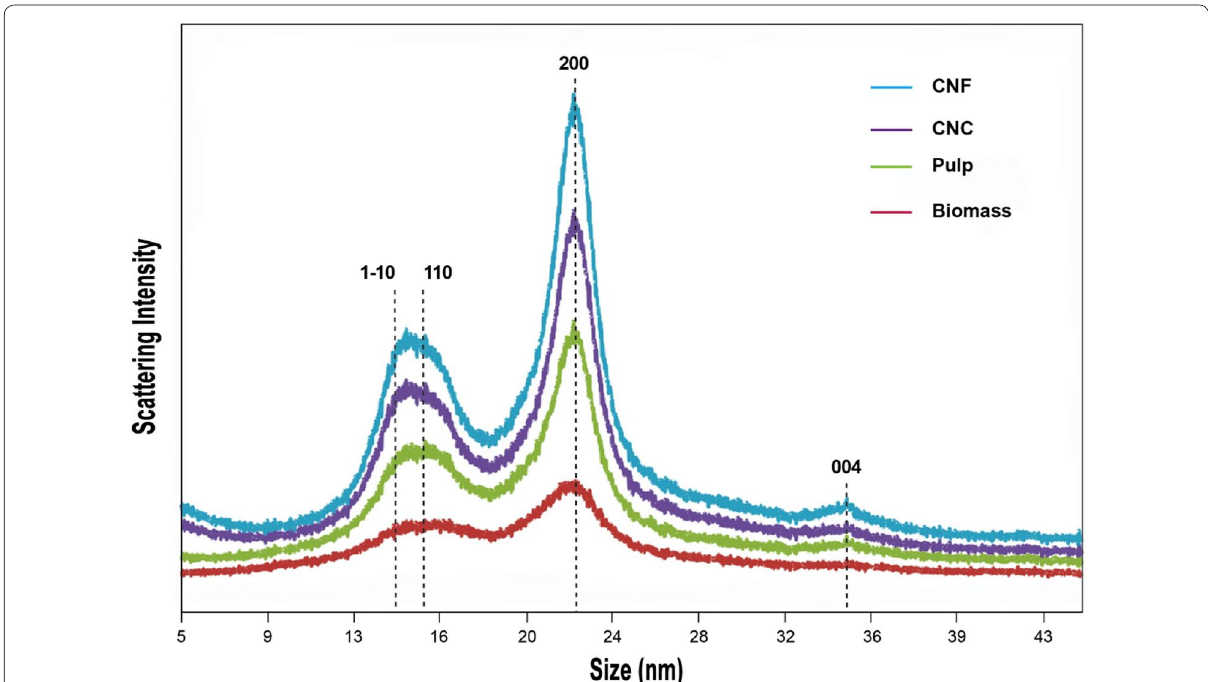
Fig. 6 XRD diffraction patterns of original biomass (red line), bleached Kraft pulp (green line), CNCs (purple line) from high CNC yielding conditions (i.e., run 4–60% w/w acid, 60 min, 55 °C, 40 mesh) and CNFs (cyan line) from high CSR yielding conditions (i.e., run 17–54% w/w acid, 45 °C, 90 min, 20